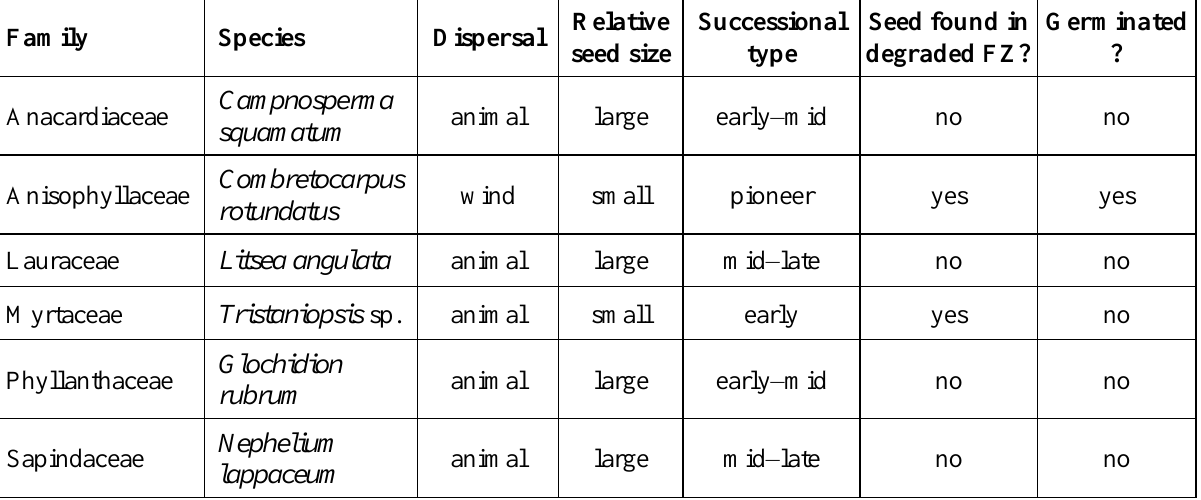
Table 2. Characteristics of the six tree species identified in the seed bank samples.